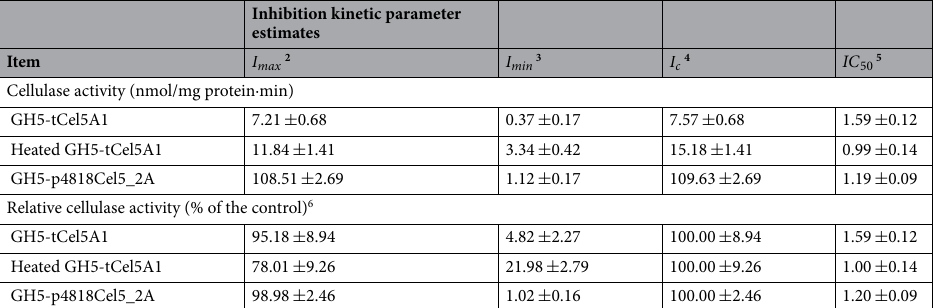
Table 4. Comparative summary of the Experiment-3 in vitro inhibition kinetics 1 of GH5-tCel5A1, the heat-treated GH5-tCel5A1 and GH5-p4818Cel5_2A under the intestinal Chymotrypsin (20 U/mL) condition obtained through the Eadie-Hofstee linear regression analyses. 1 Values are parameter estimates or means ± SE (n = 72) obtained through the Eadie-Hofstee regression linear analyses, representing the inhibition kinetic parameter estimates obtained from the three chymotrypsin (20 U/mL) inhibition experiments with 4 replicates per time point in each experiment, as shown in Figs. 15, 16, 17. 2 I max is the maximal magnitude of inhibition in the cellulase activity (nmol/mg protein·min or % of the control, means ± SE, n = 12) calculated according to Eq. (2). 3 I min is the minimal residual cellulase activity (nmol/mg protein·min or % of the control I c ; parameter estimate ± SE, n = 72) under the intestinal chymotrypsin (20 U/mL) inhibition condition obtained from Eq. (1). 4 I c is the mean cellulase activity of the control group (nmol/mg protein·min or % of the control, means ± SE, n = 12). 5 IC 50 is the incubation time (h, parameter estimate ± SE, n = 72) required to reach the half maximal inhibition of the cellulase activity. 6 Relative cellulase activity calculated as percentage (%, means ± SE, n = 12) of the control group ( I c ) measured at 0-min exposure to the intestinal chymotrypsin (20 U/mL)